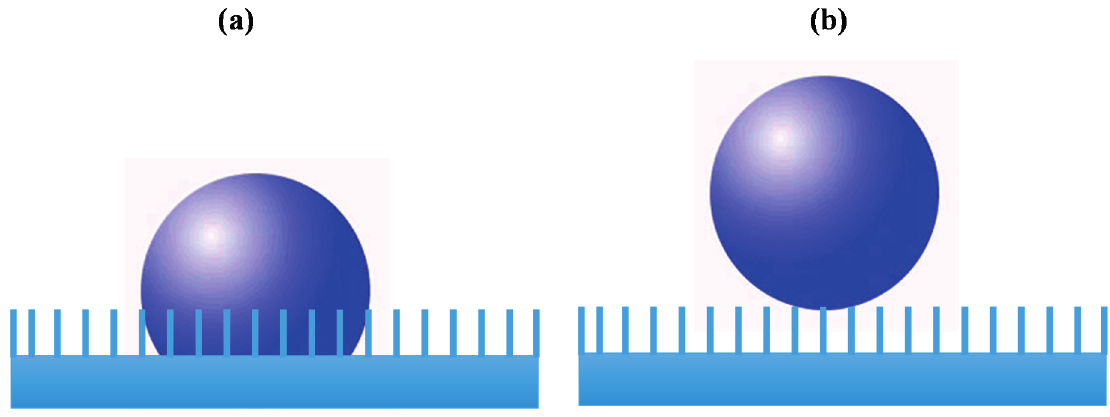
Figure 2. ( a ) Wendzel droplet (occurring when a water droplet merges with a surface) and ( b ) Cassie droplet (occurring when a water droplet is positioned on the surface) above nanosized pockets of ambient